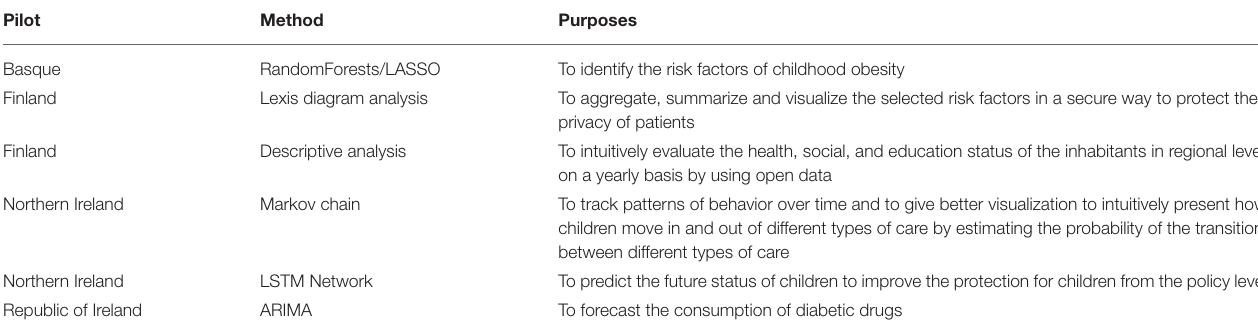
TABLE 2 | Pilot-specific